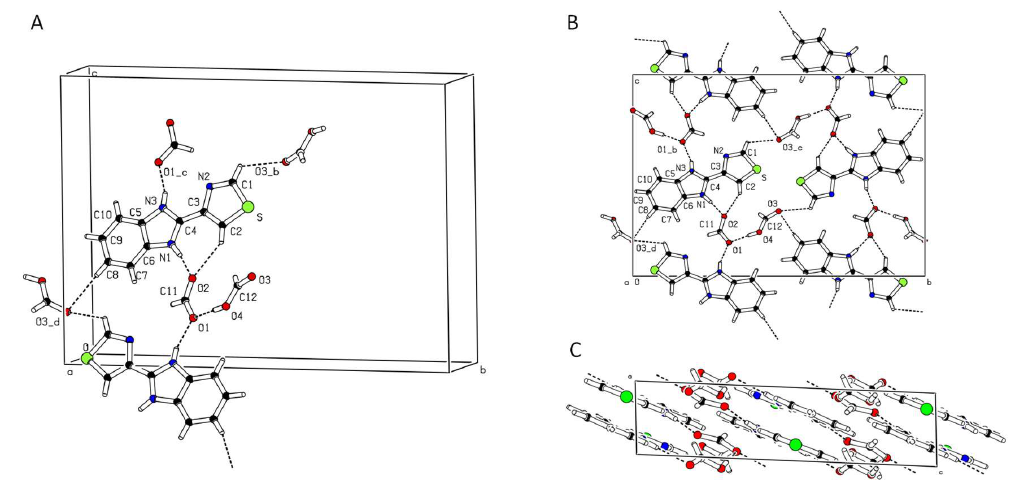
Figure 9. Crystal structure of Thiabendazole (TBZ)-formic acid solvate viewed in perspective ( A ), as a projection along the c -axis showing the hydrogen bonding pattern in the molecular layers ( B ), and as a projection along the b -axis showing the packing consisting of stacked molecular layers ( C ).